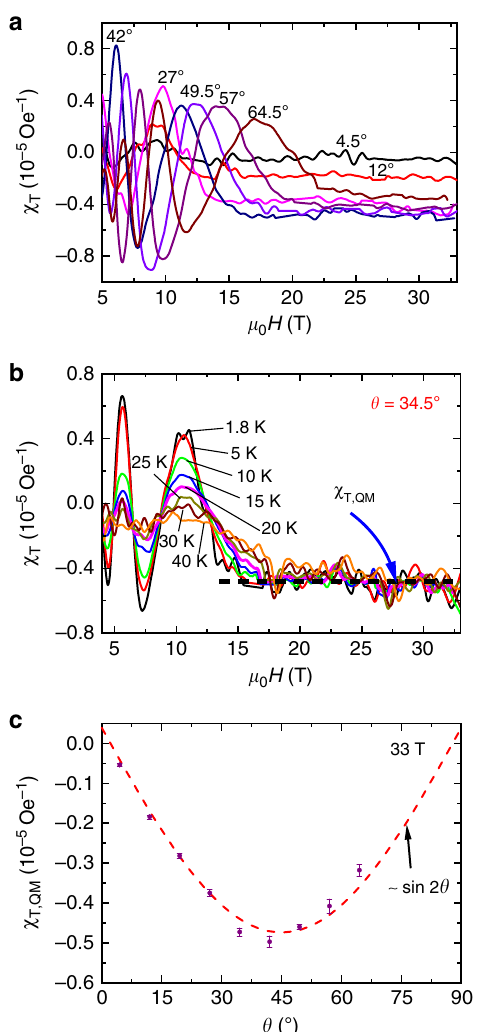
Fig. 3 Differential effective susceptibility ( χ T ) for TaAs. a χ T at different angles. b χ T for θ = 34.5° at different temperatures. c The heights of the χ T plateaus at 33 T versus angles. Red dashed line shows the fi tting with a relation of sin 2 θ . The error bars were obtained from the standard deviations of intercepts when fi tting to the step behaviors in the quantum